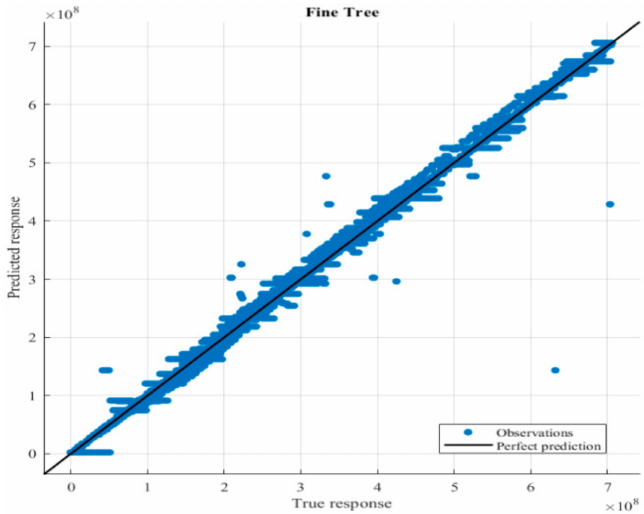
Figure 9. Fine Trees Prediction vs. Actual training.